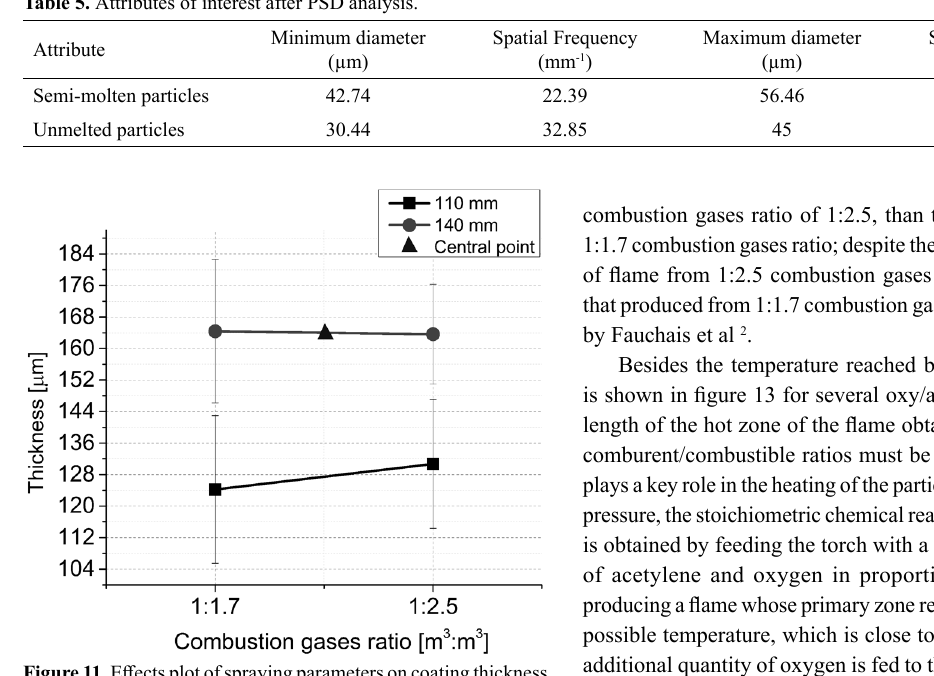
Figure 11. Effects plot of spraying parameters on coating thickness